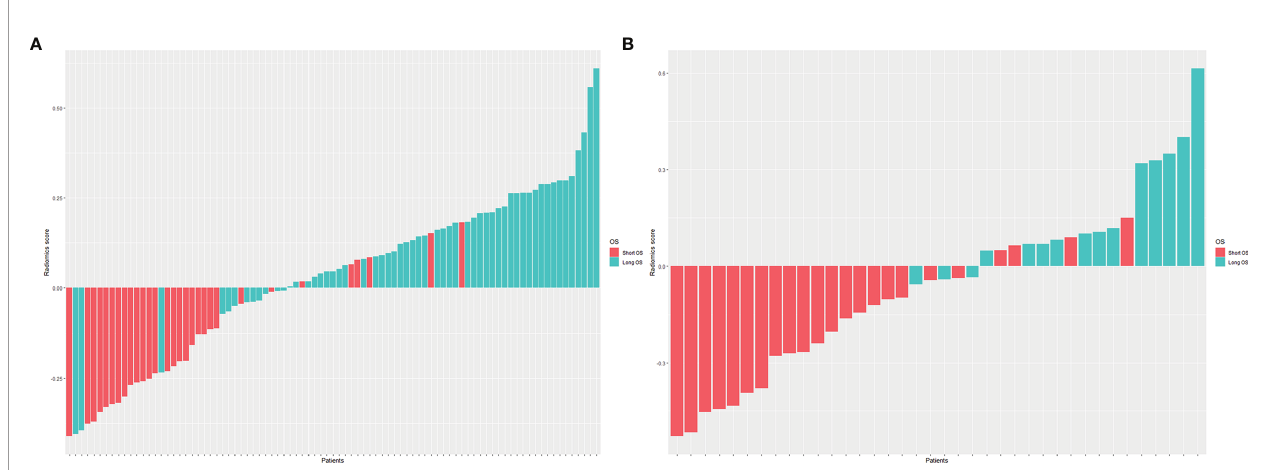
FIGURE 3 | The histogram of Radscore for each patient in the training cohort (A) and validation cohort (B) . The red bars showed the Radscore values for the short OS patients, and the blue bars showed the values for the long OS patients. Patients with long OS showed higher Radscores than patients with short OS in both the training and validation cohorts.